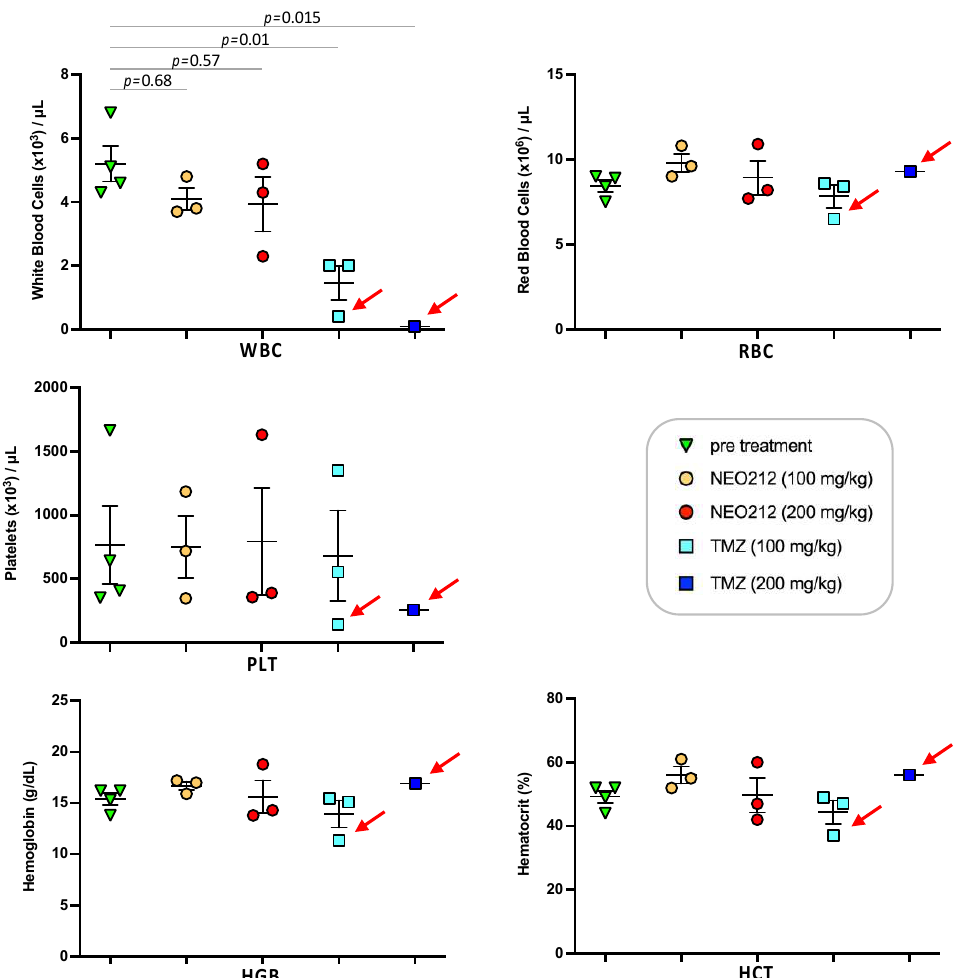
Figure 9. High-dose NEO212 does not impact survival. Three rats per group received one 5-day cycle of daily treatments with NEO212 or TMZ. Shown is survival of animals after treatment with 100 mg/kg per dose ( left panel ) and 200 mg/kg per dose ( right panel ). Green arrows indicate treat- ment days.